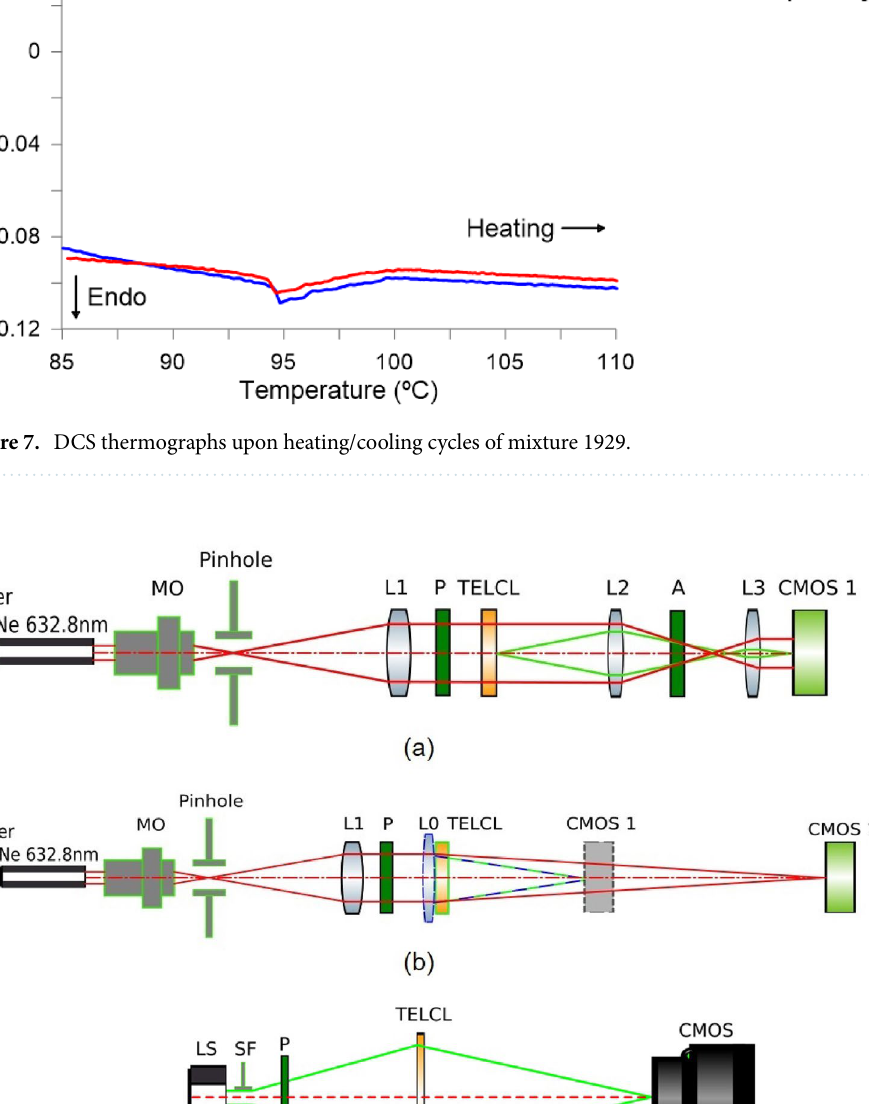
polarization axis is parallel to the liquid crystal director. While measuring positive focal lengths of TELCL there is no L0 lens in the setup (light rays represented as red line). Therefore, the focal estimate is the distance from TELCL on which the tiniest light spot can be acquired on CMOS1 camera. For measuring negative focal lengths, an additional biconvex lens (L0) is added close to TELCL (light rays are represented as a blue-green line). Therefore, the distance on which the smallest spot can be seen on CMOS camera is the focal length of the two lens systems (biconvex and TELCL). Because they were near each other, we can assume that their optical powers